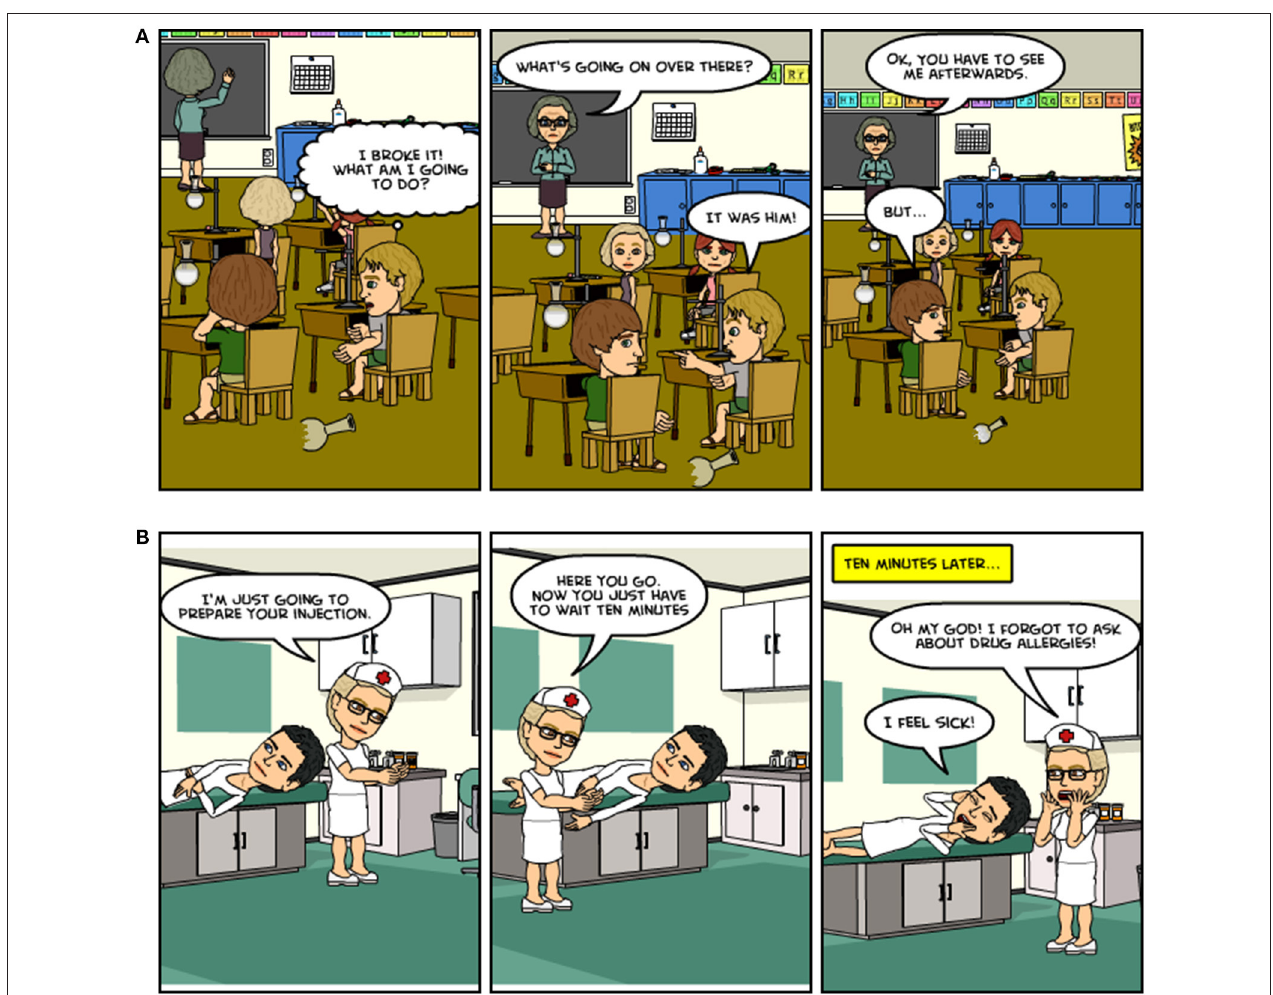
FIGURE 1 | (A) An example of a scene from the EMOTICOM Moral Emotions task depicting both the victim and victimiser of deliberate harm . (B) An example of a scene from the EMOTICOM Moral Emotions task depicting both the victim and victimiser of accidental harm.